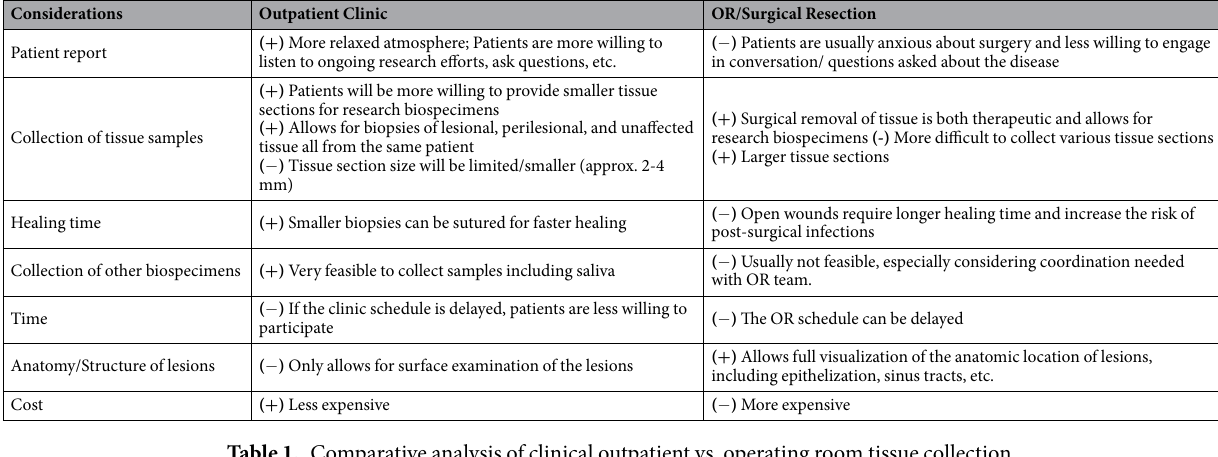
Table 1. Comparative analysis of clinical outpatient vs. operating room tissue